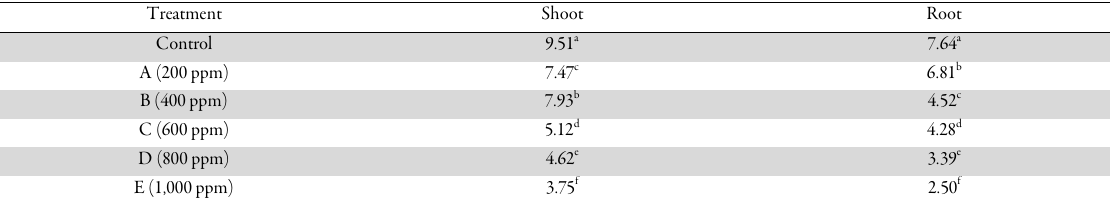
Table 2. Plant biomass (g) of Pityrogramma calomelannos after growing for 12 weeks in lead contaminated soil